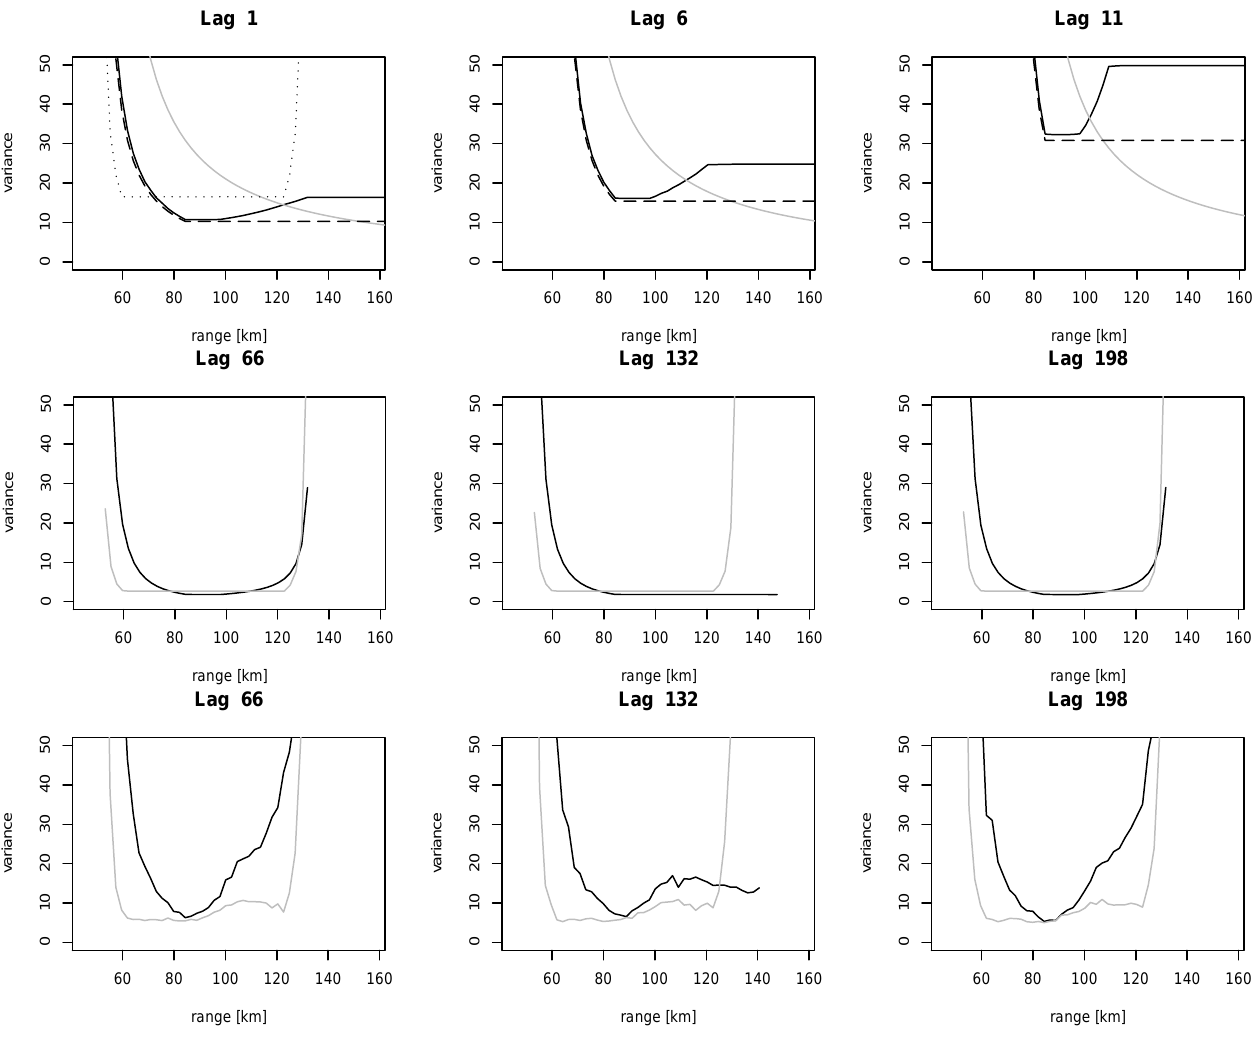
Fig. 6. Top panel: The bottom parts of the normalised lag profile variances in the compared experiments. The black, grey, dashed and dotted lines are variances in PPATC experiment, exp1, exp2 and exp3, respectively. The differences in the estimation accuracies at the lowest ranges are clearly visible. Middle panel: Normalised variances for the pulse-to-pulse lags of the PPATC experiment and exp3 for low SNR. All possible fractional lags around each main pulse-to-pulse lag are included in the same profiles. The lags are numbered as multiples of the bit length of the phase codes. Bottom panel: sample variances of the inversion results of simulated data for the pulse-to-pulse lags. In total 314 inversion results have been used for each variance